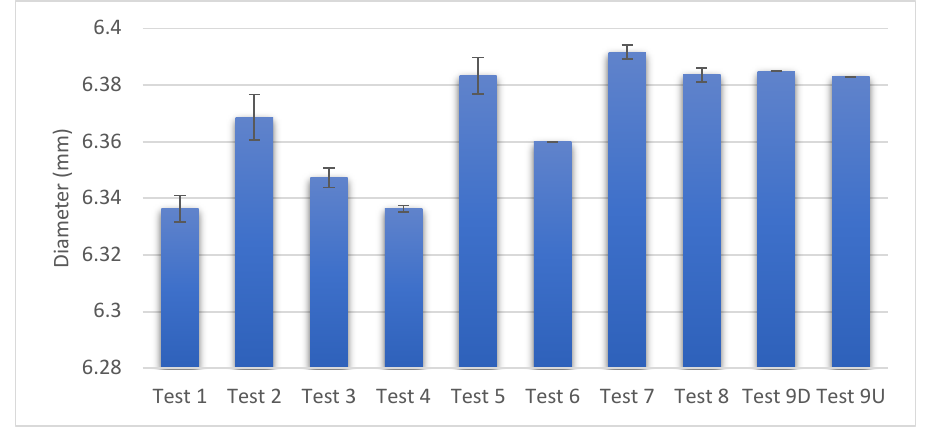
Figure 11. Graph of diameter results.